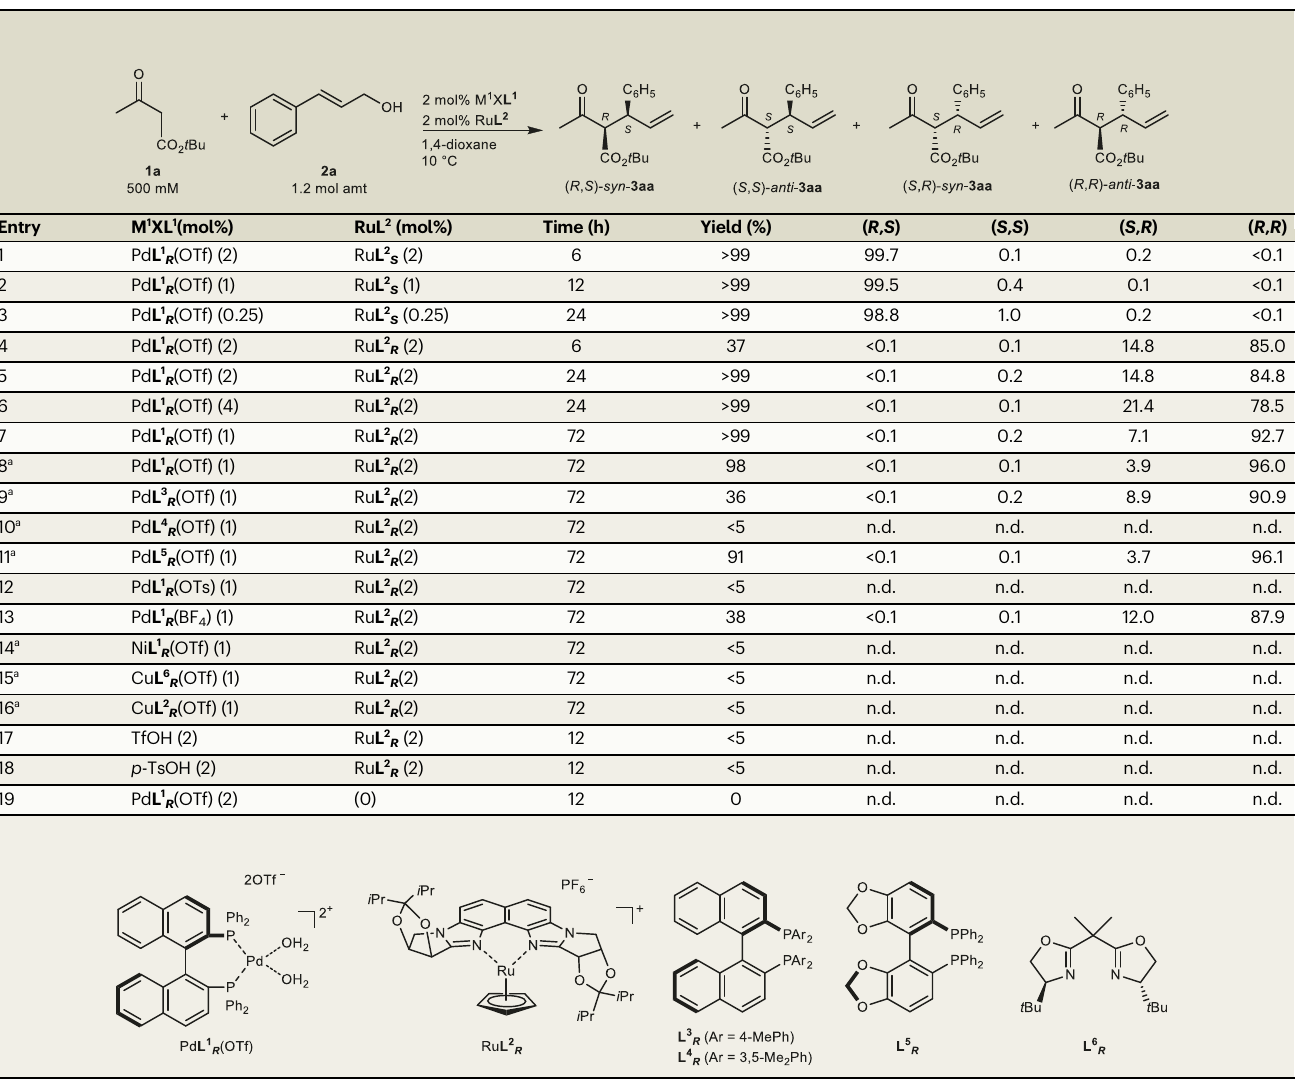
Table 1 | Screening of two metal complexes catalyzing the dehydrative allylation of 1a and